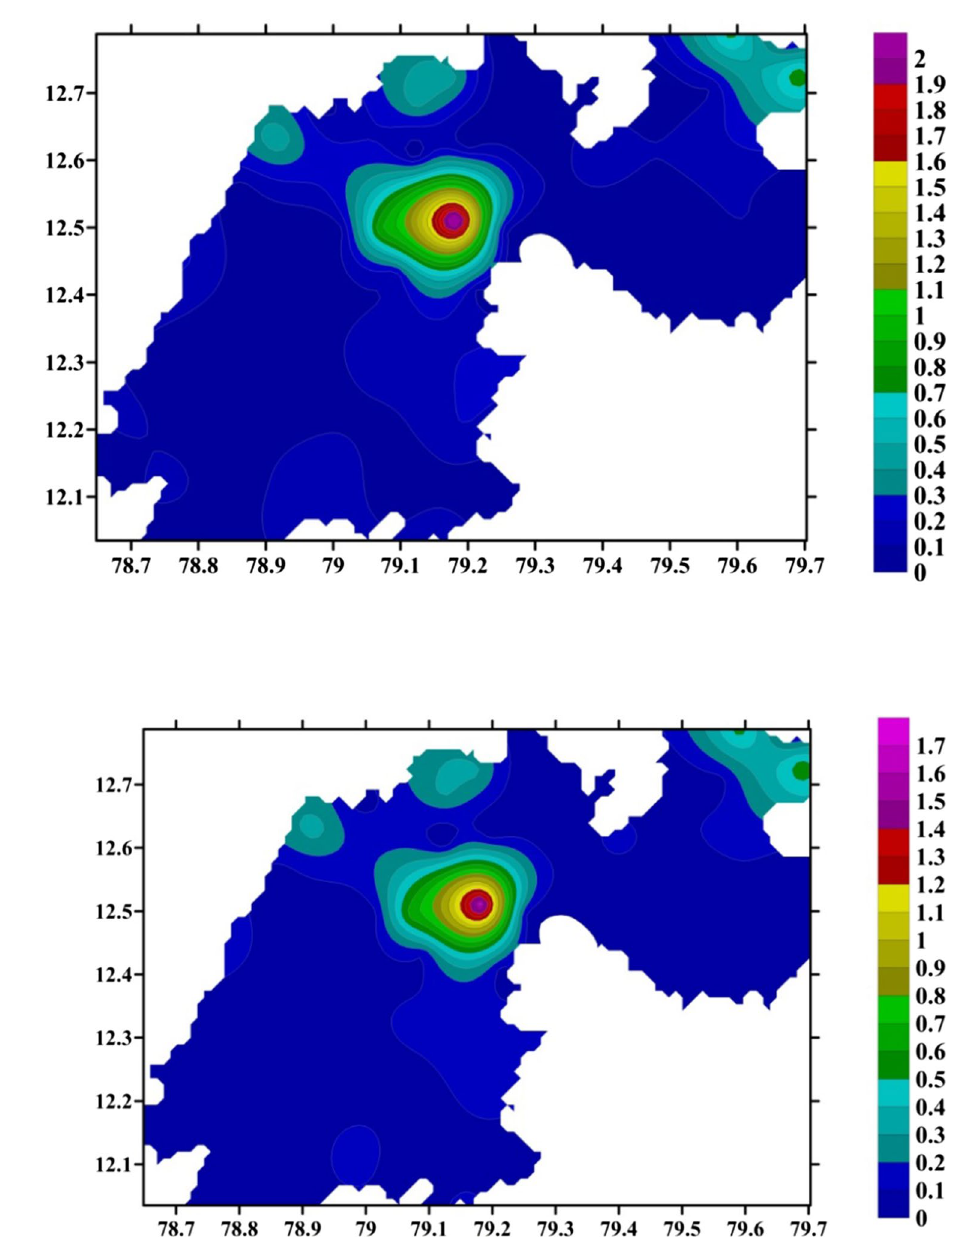
Fig. 15 Spatial distribution of LADD in the study area for adult males